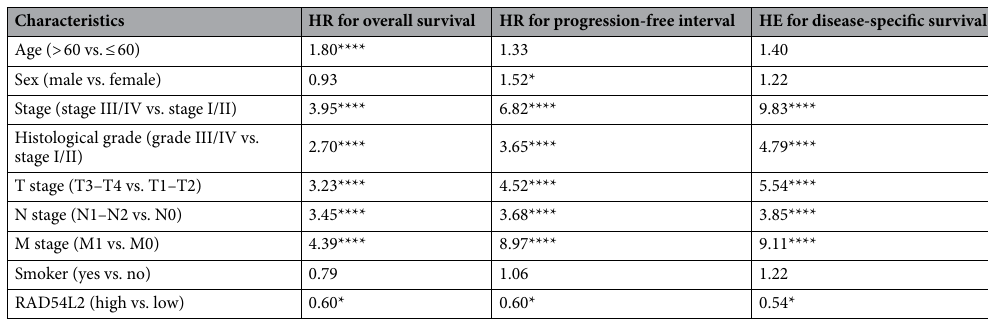
Table 3. Cox regression analysis for clinical outcomes in RCC patients. HR hazard ratio; *p < 0.05; ****p <